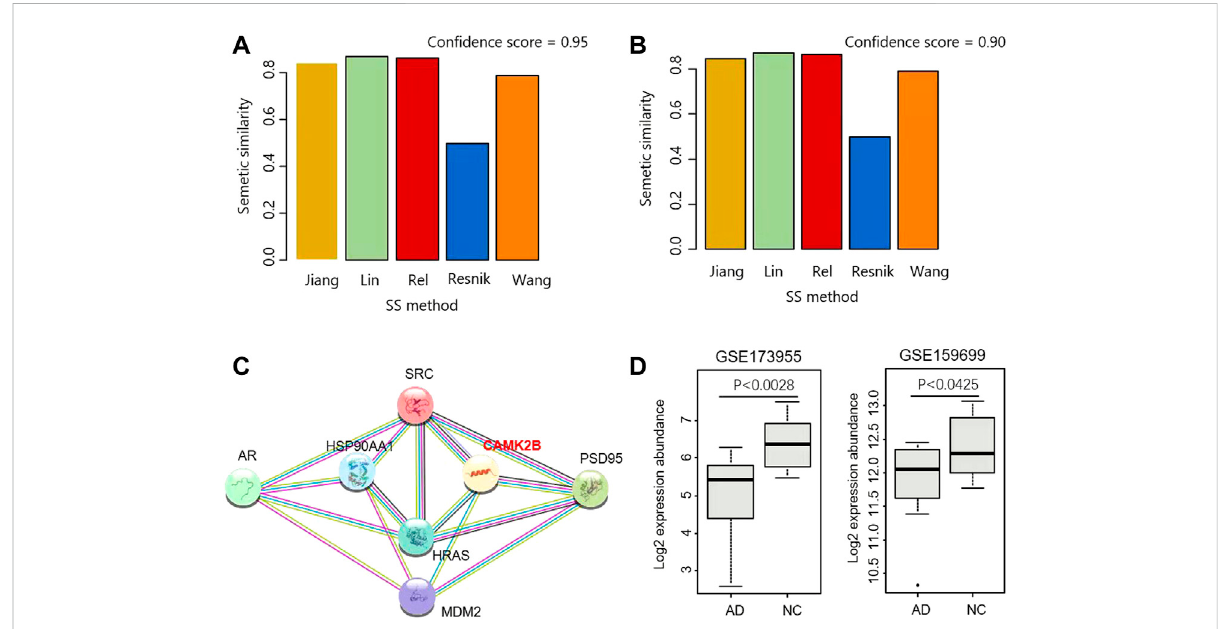
FIGURE 3 Identi fi cation of CaMKII as a mediator for androgen and PSD95. (A,B) SS scores were calculated by fi ve methods based on the ICS threshold of 0.95 (A) and 0.9 (B) , respectively. (C) Interaction network including AR, PSD95 and their mediators. (D) CAMK2B were differentially expressed in two datasets GSE173955 and